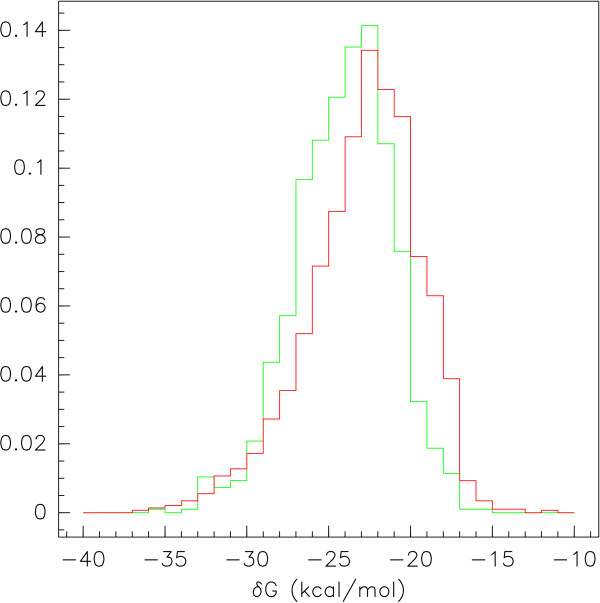
Thermodynamic Distribution of Experimental Sequences. Empirical thermodynamic distributions of experimental antisense sequences. The curves represent the distribution of Gibbs free energy (dG) for the effective (green) and ineffective (red) antisense sequences. The average dG for the effective sequences (-24.04 kcal/mol) was significantly more negative than the average dG for the ineffective sequences (-22.80 kcal/mol).